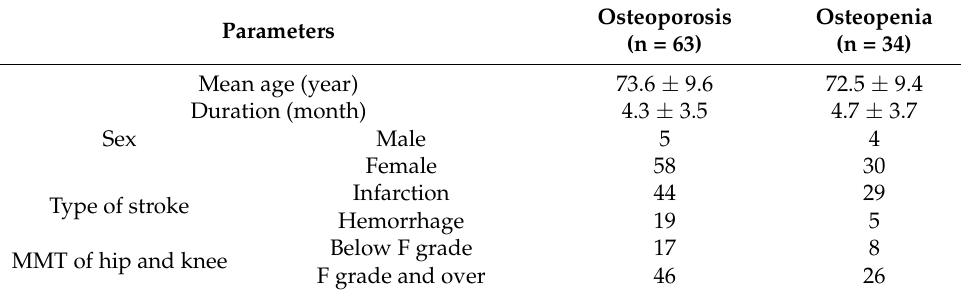
Table 1. General characteristics of the